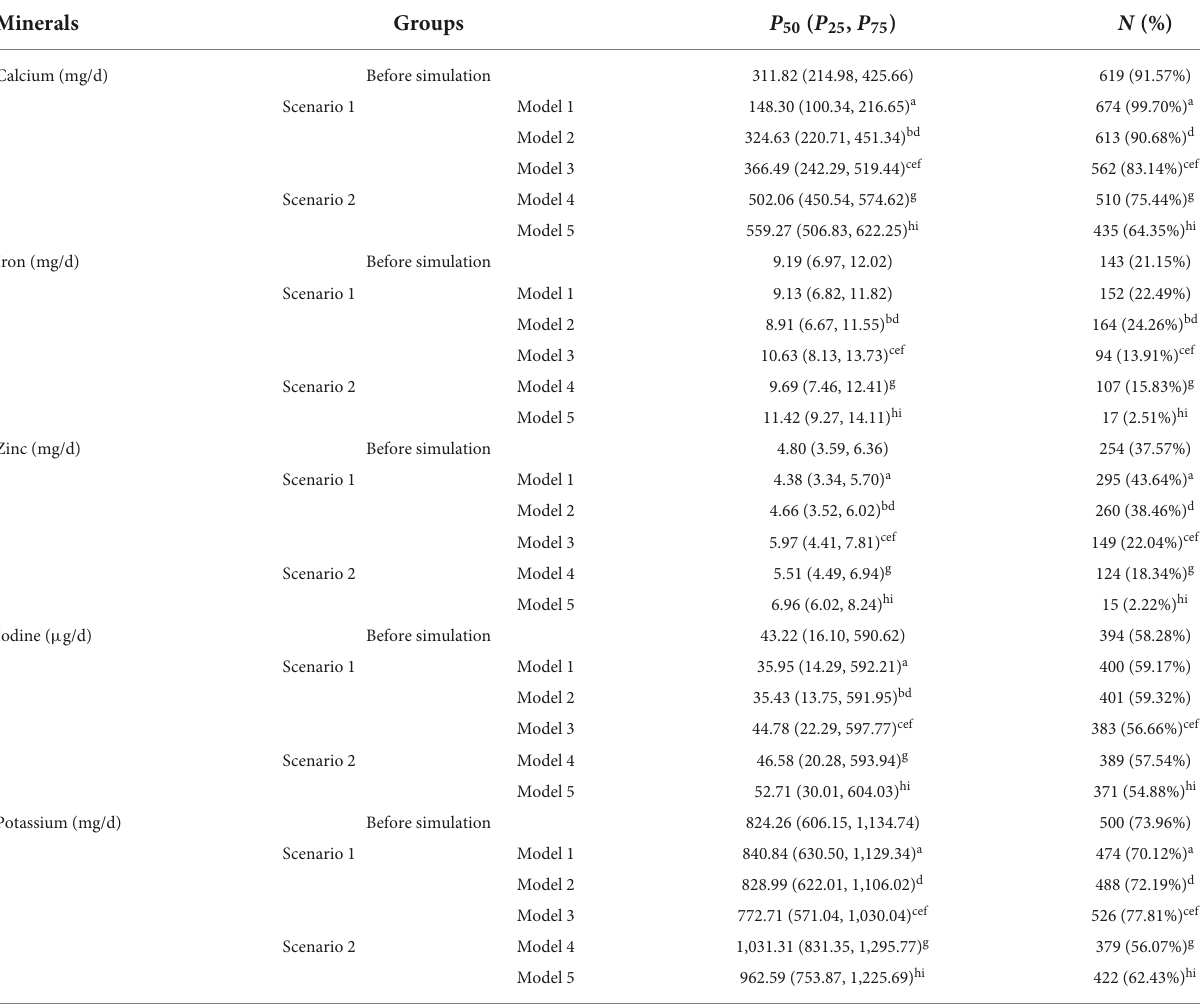
TABLE 5 Mineral intakes after simulation ( n =